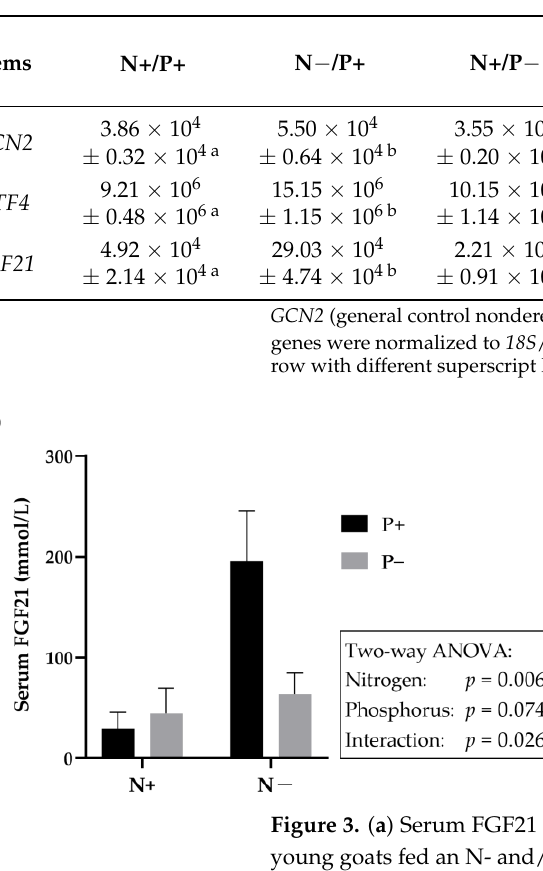
Table 6. Relative amounts of GCN2 , ATF4 , and FGF21 -mRNA level in the livers of young goats fed an N- and/or P-reduced diet.